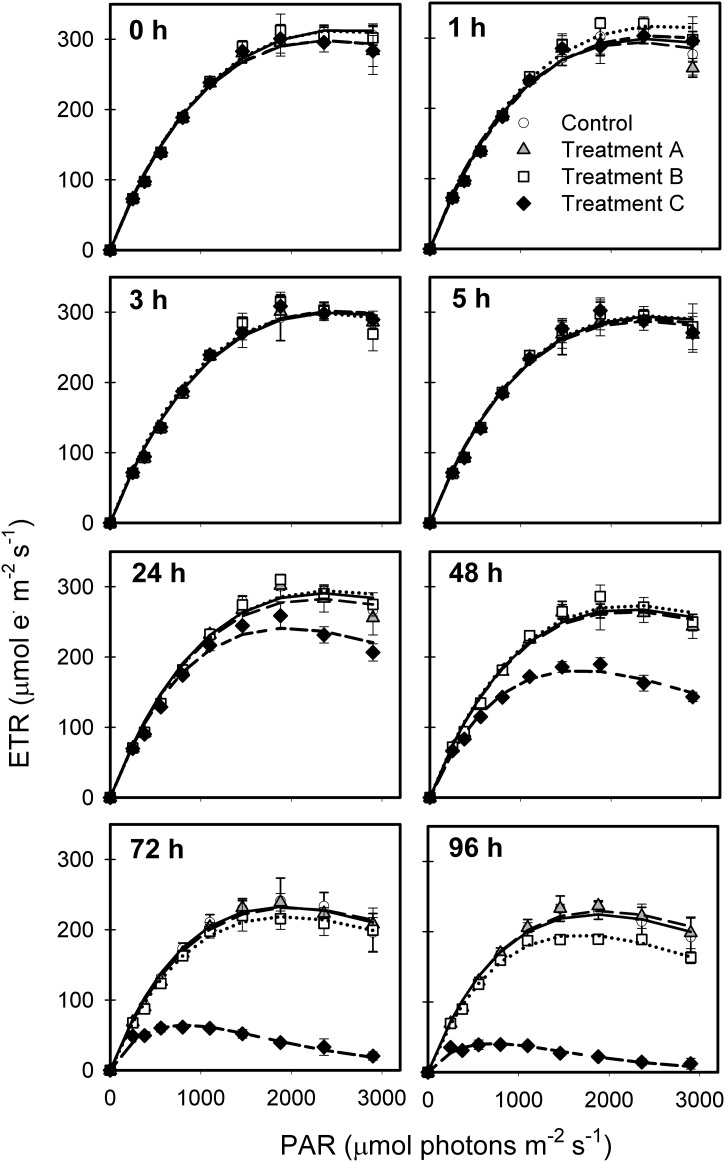
Effects of metformin on electron transport rates (ETR).Parameters were estimated by models of best fit according to Platt (1980) and include electron transport efficiency (α), photoinhibition (β), maximum relative electron transport rate (ETRmax), and minimum saturating irradiance (Ek). Symbols indicate different metformin additions: 0 μg L-1 (black circles), 1.5 mg L-1 (open squares), 76.8 mg L-1 (open diamonds), and 767.8 mg L-1 (open triangles).